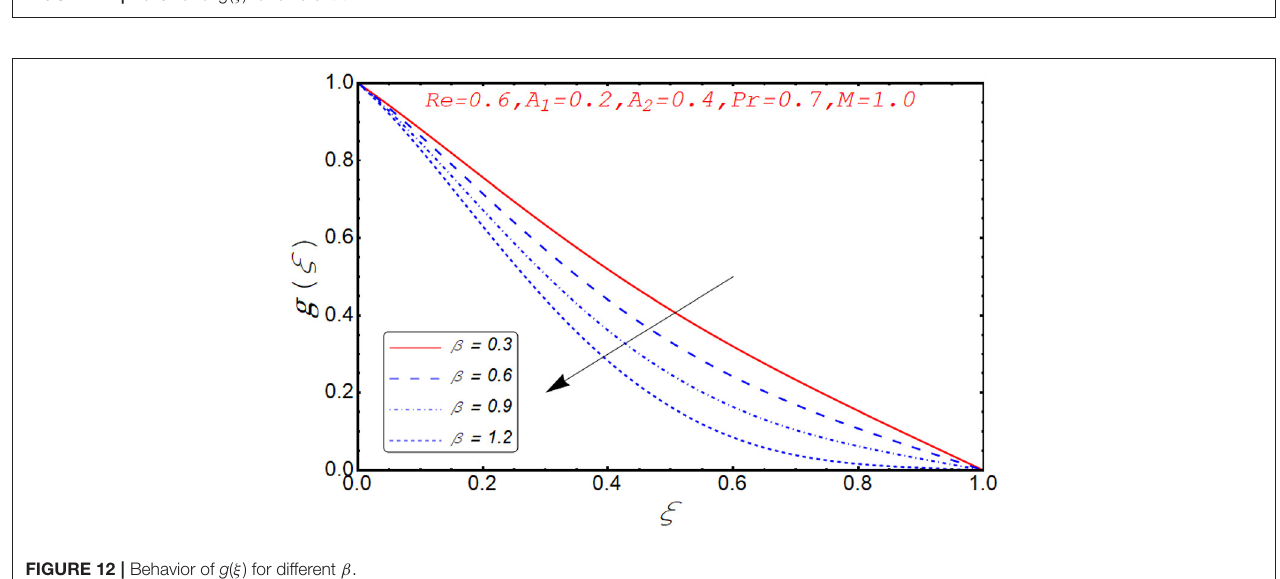
FIGURE 11 | Behavior of g ( ξ ) for different τ .